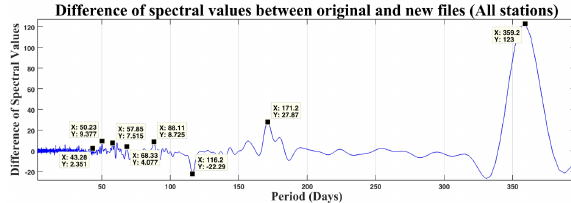
Figure 14: difference between spectral values for original and new time series (all station) - X is period and Y is difference of spectral